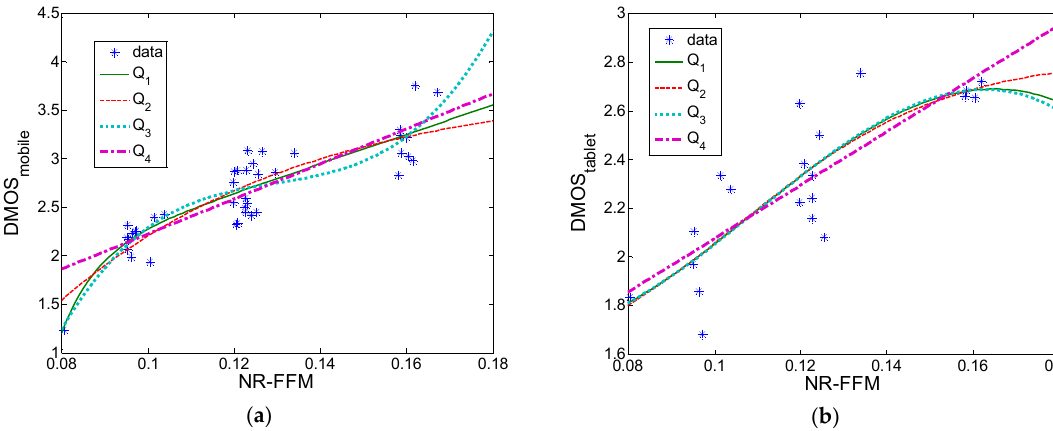
Figure 4. No-reference frame–freezing measure (NR-FFM) versus DMOS (trained using LIVE mobile sub-dataset): ( a ) LIVE mobile dataset; ( b ) LIVE tablet dataset. Table 7. Fitting coefficients b 1 -b 5.